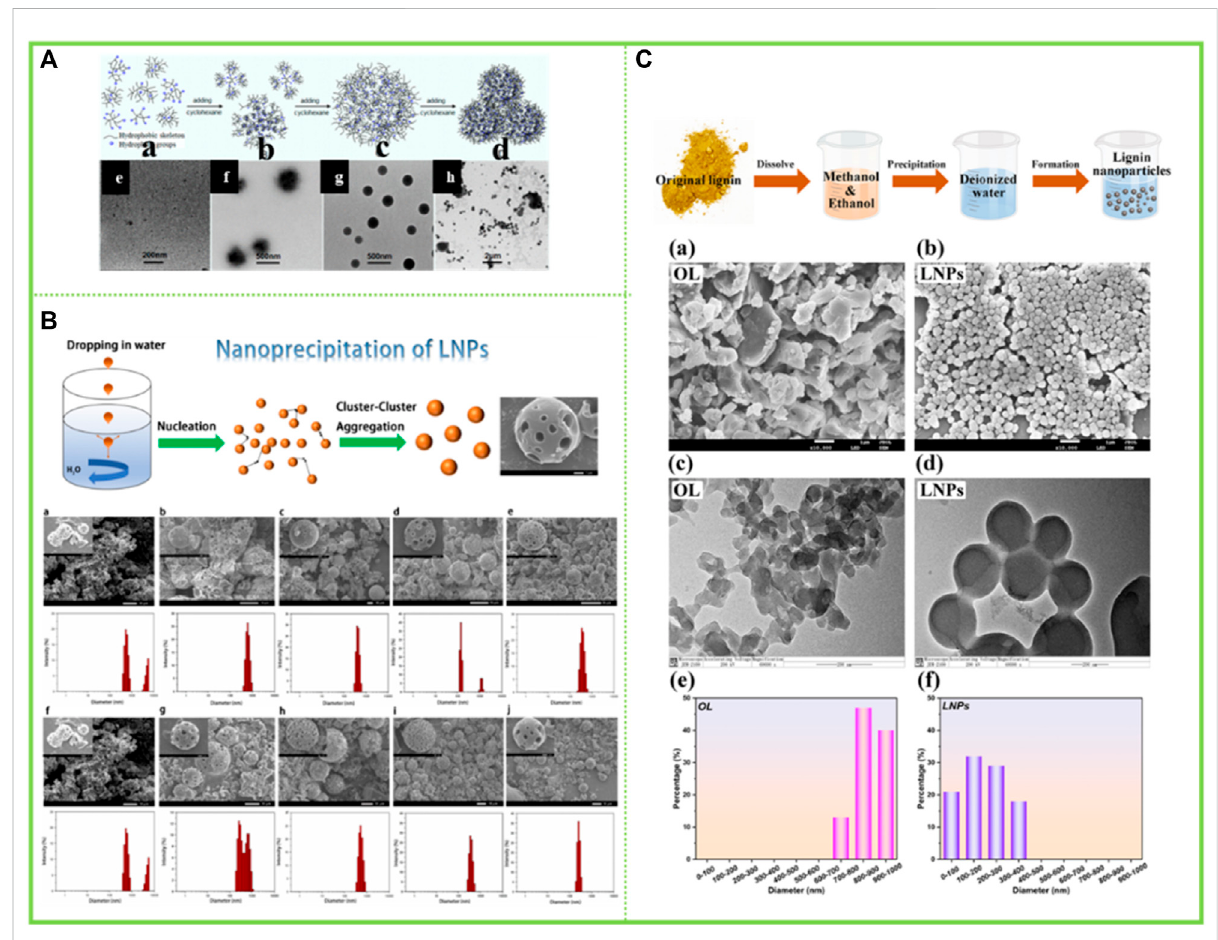
FIGURE 5 (A) SchematicrepresentationoftheformationprocessofLRM indioxane − cyclohexanemediumandTEMimages ofsamplesobtained fromthe dispersions with different cyclohexane contents (Qian et al., 2015a) (B) Lignin nanoparticle (LNP) formation mechanism during dropping nanoprecipitation, Scanning electron microscopy (SEM) images of LNCs (Yang et al., 2022) (C) Schematic diagram for the synthesis of LNCs, SEM images of (a) OL and (b) LNCs, TEM images of (c) OL and (d) LNCs, and nanoparticle size distribution of (e) OL and (f) LNCs (Du et al., 2022). (A) Copyright 2015 American Chemical Society (B – C) Copyright 2022